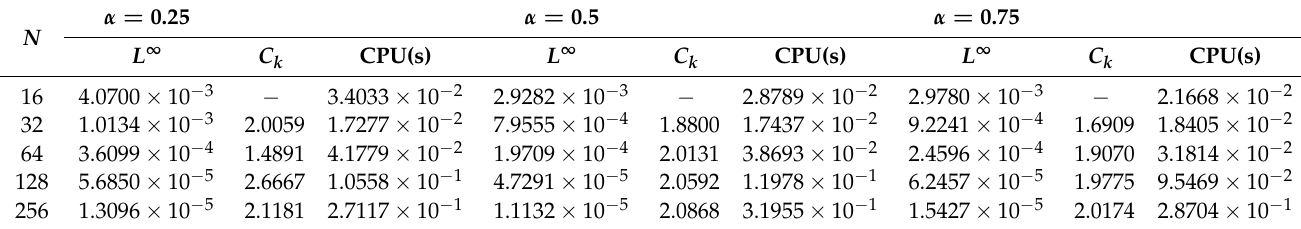
Table 2. The maximum norm errors L ∞ and temporal convergence rates C k with h = k